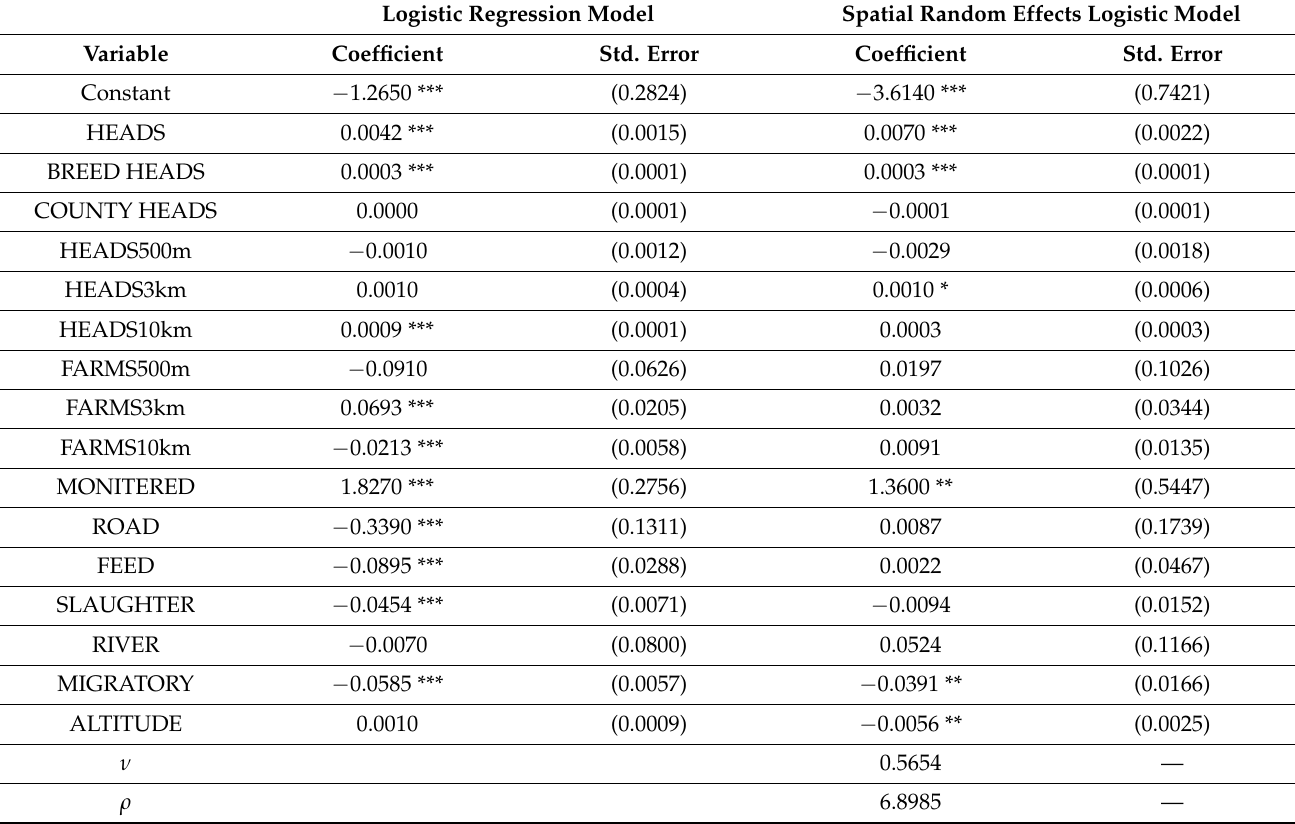
Table 3. Estimation results and probability of a farm being infected with HPAI. Logistic Regression